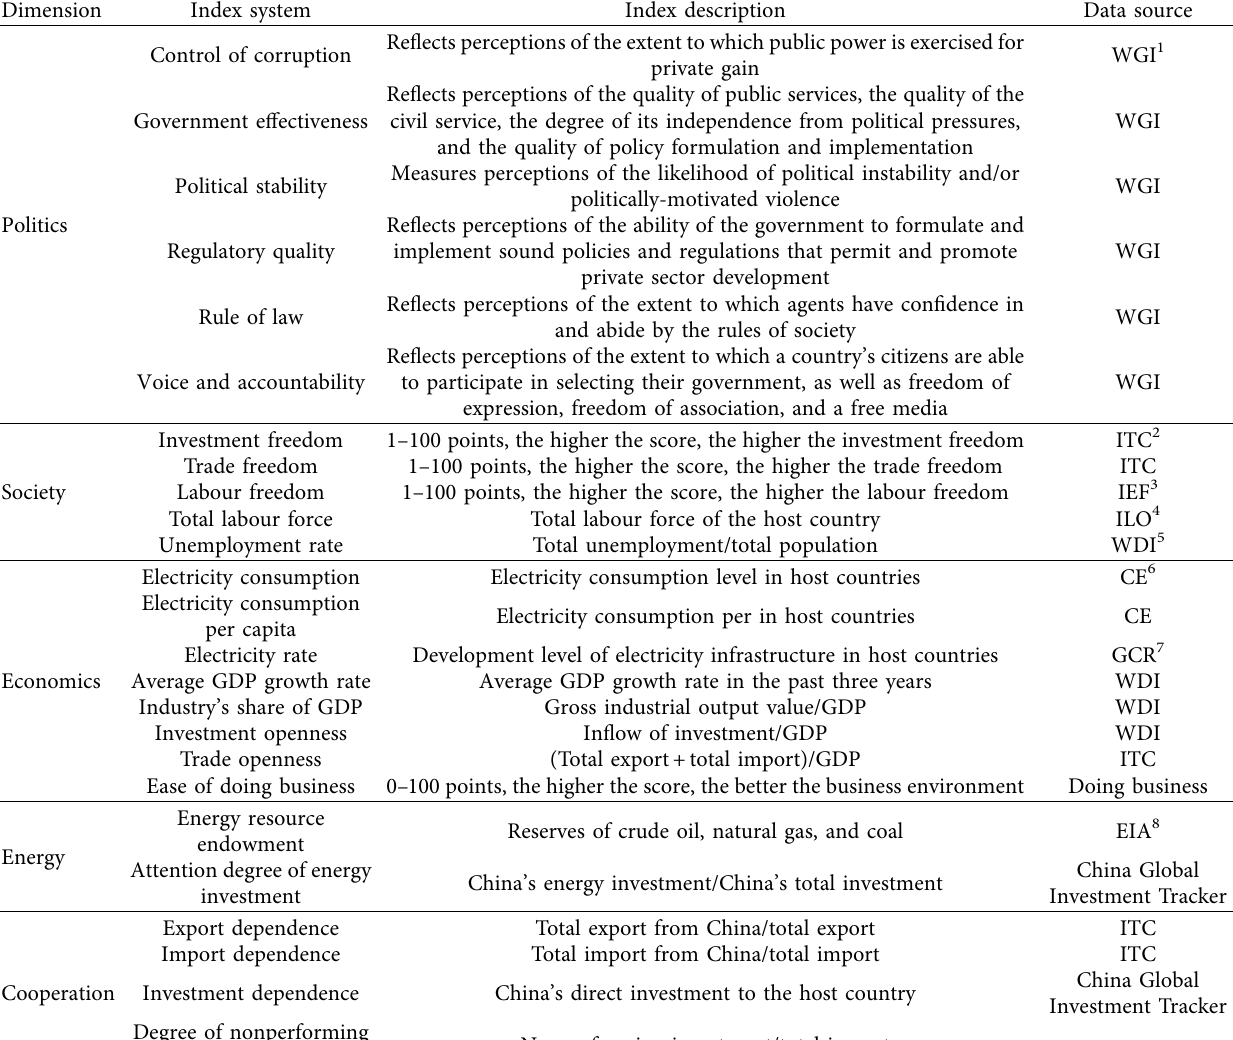
Table 1: Description of